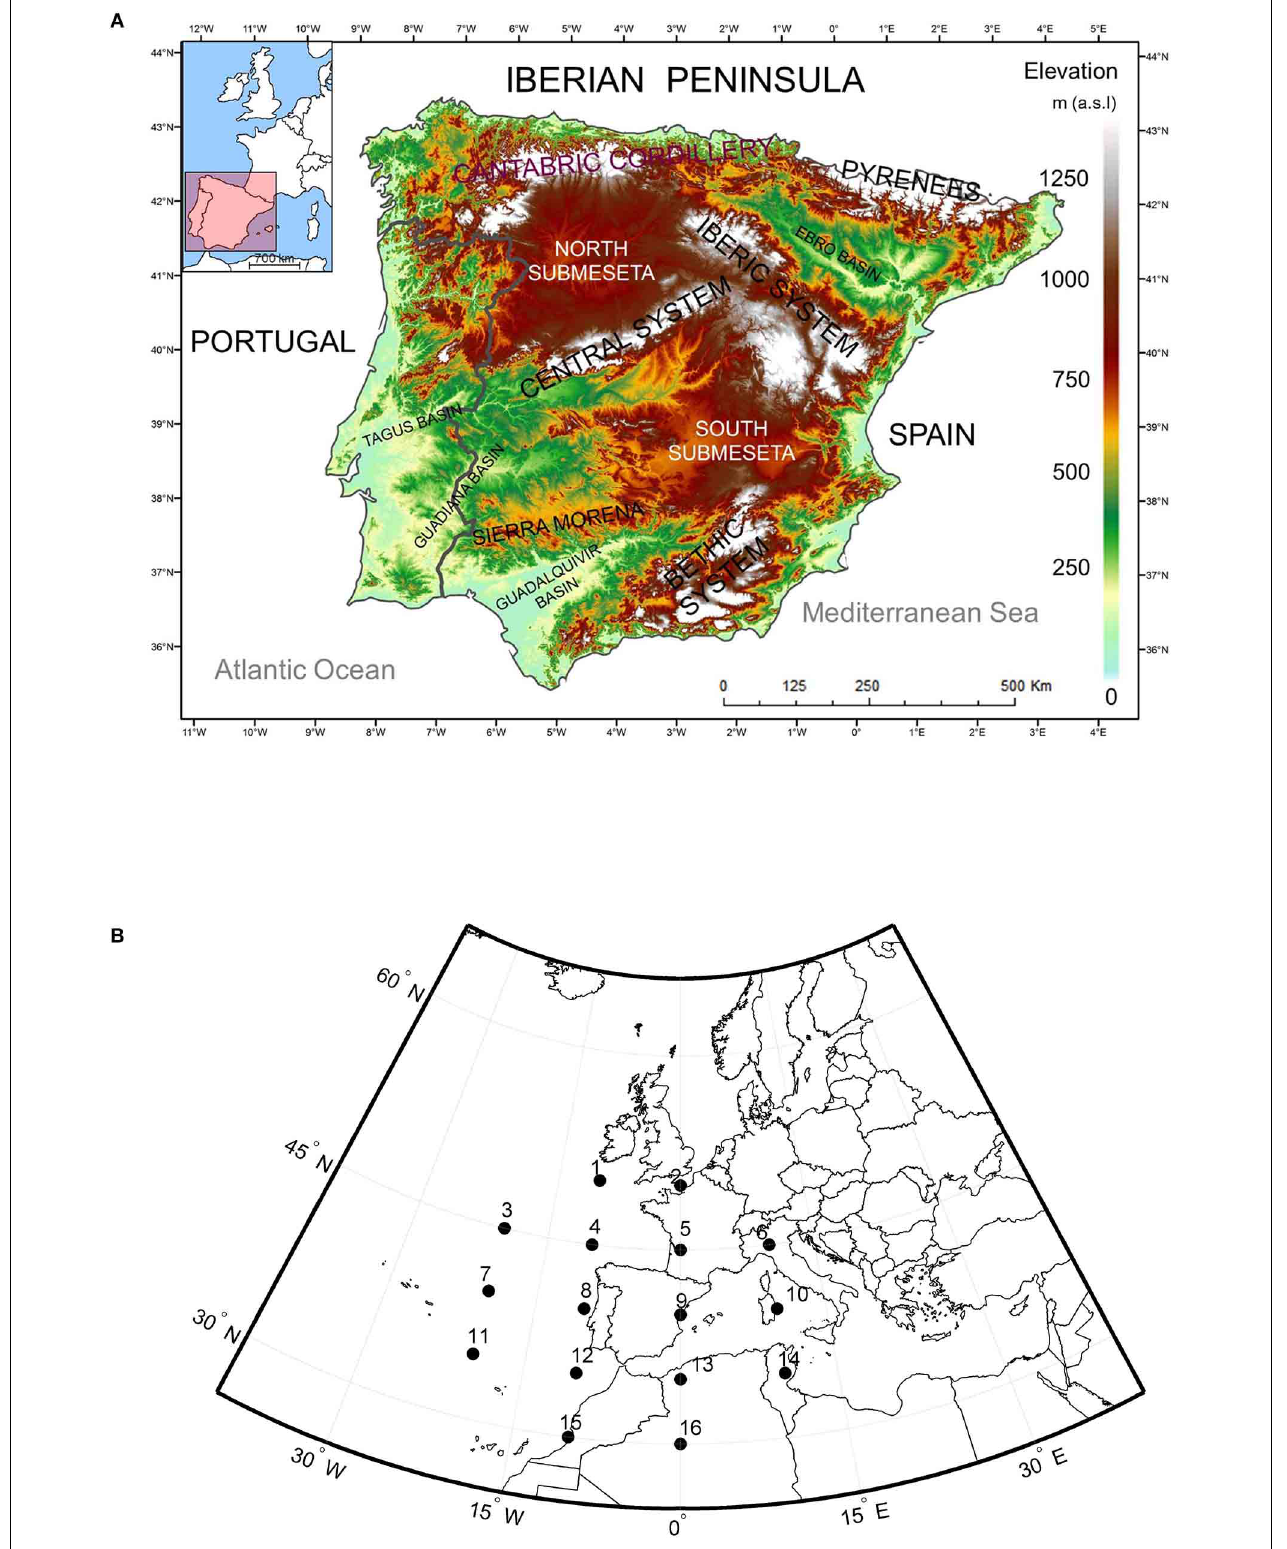
FIGURE 1 | (A) Main Mountain Ranges and Depressions of the Iberian Peninsula and (B) 16 SLP grid points used in the WTs computation.